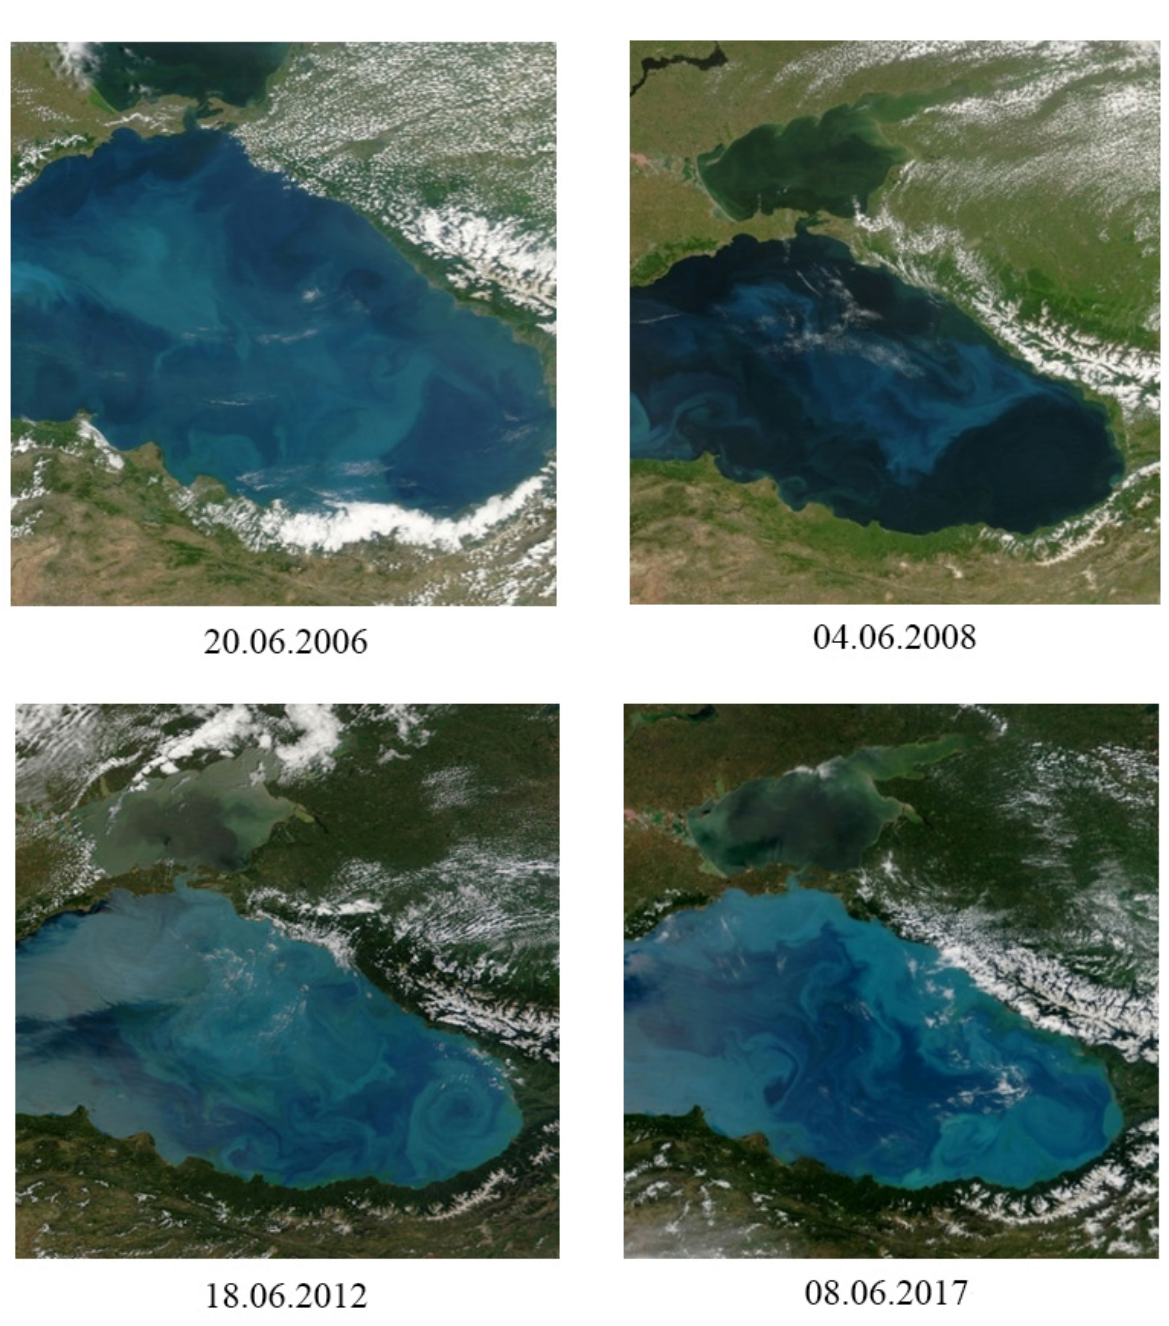
Figure 13. Distribution of coccolithophores in Batumi anticyclone during the summer blooms of 2006, 2008, 2012, 2017. Source (https://visibleearth.nasa.gov, accessed on 15 December 2021). In addition to the interannual differences, the cardinal changes in the coccolithophore were recorded during one-year summer bloom development. So, in May 2008, after forming a blooming spot in the Batumi anticyclone, the degradation of the blooming area was already recorded in June (Figure 14). Moreover, the degradation mentioned took place in the opposite phase to further coccolithophores development in the total sea area.